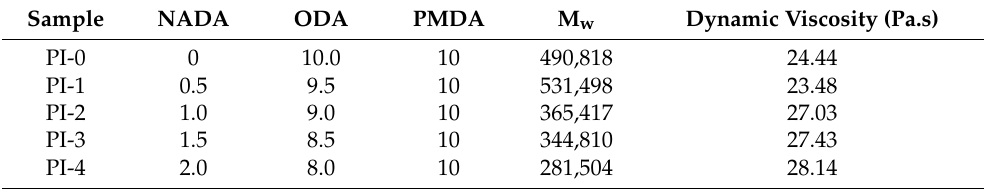
Table 1. Relative molecular weight and dynamic viscosity of monomer, PAA with different molar ratios.